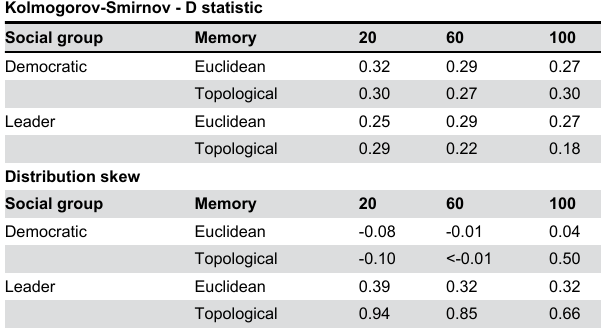
Table 2. Comparison of daily step length between simulated and observed primate groups; all comparisons with the K-S test were found to be significantly different